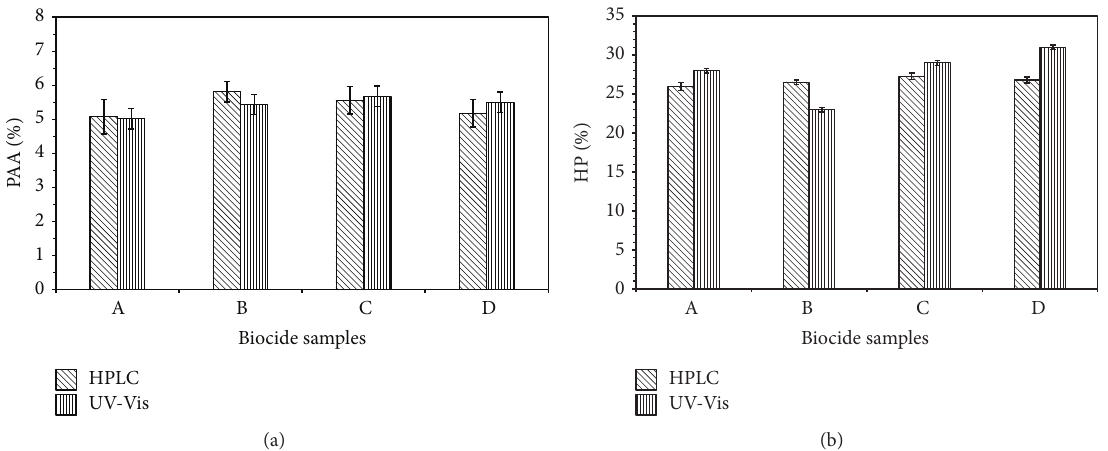
Figure 3: Analysis of PAA (a) and HP (b) in biocide samples using a simultaneous HPLC/UV determination and UV/Vis spectroscopy methods.